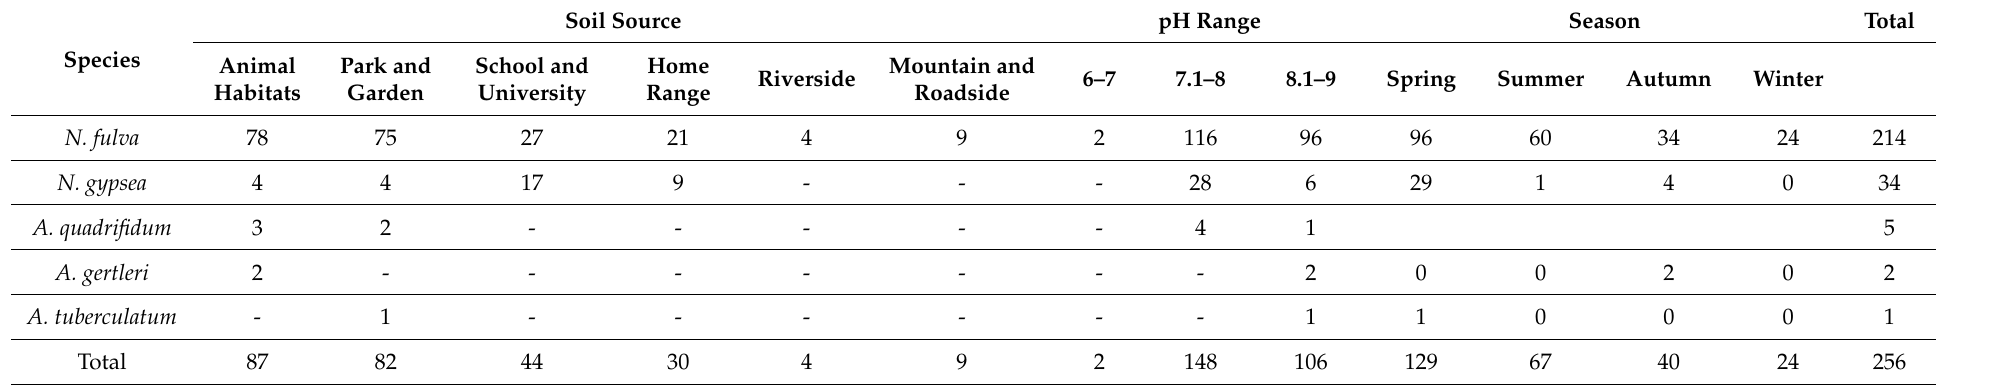
Table 1. Distribution of the geophilic isolates regarding the sources and pH of the soils.